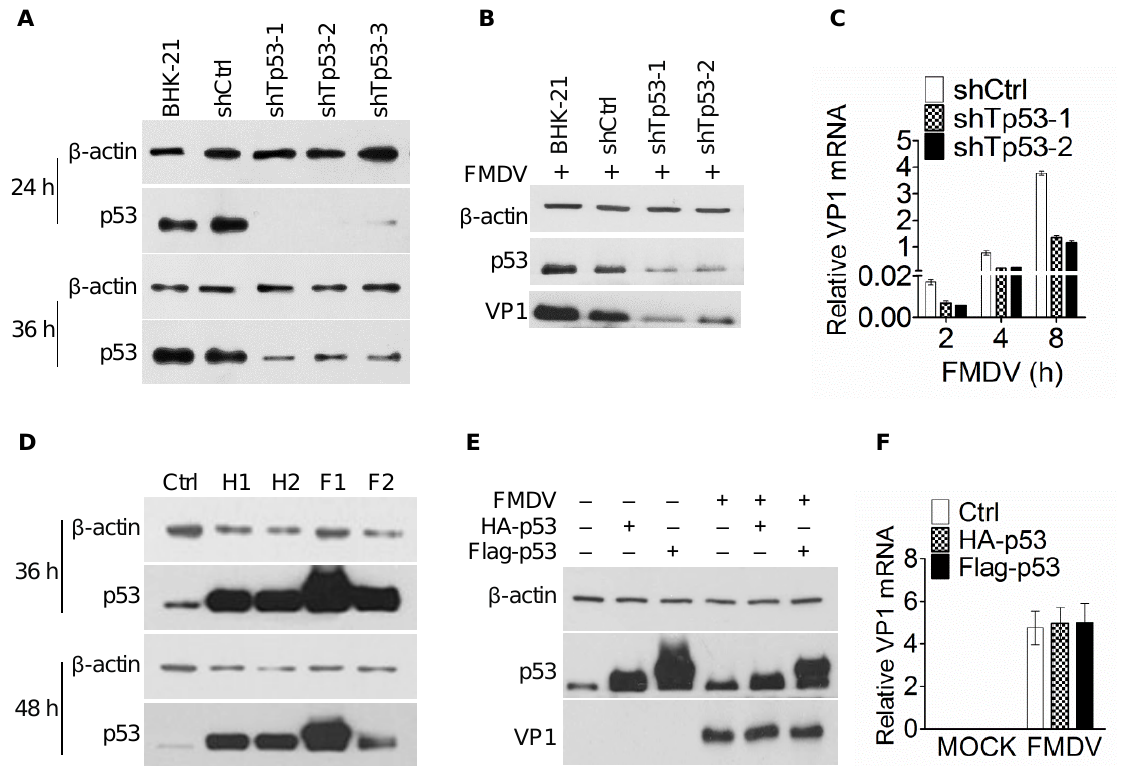
Figure 2. p53 knockdown reduced FMDV replication while its overexpression had no e ff ect in